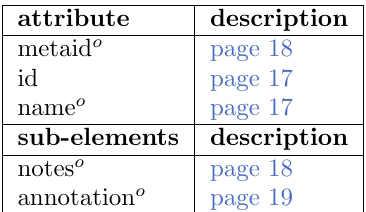
Table 2.20: Attributes and nested elements for abstractTask. xy o denotes optional elements and